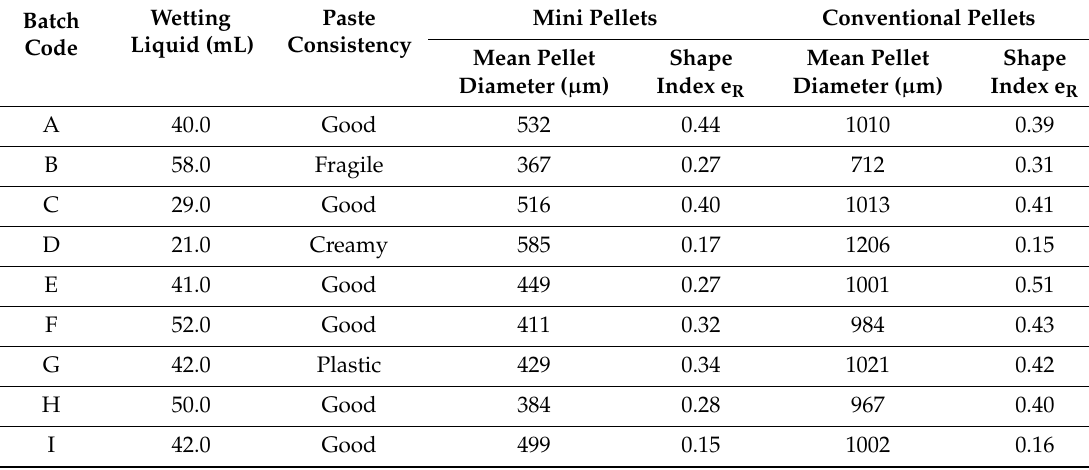
Table 3. Wetting liquid consumption, paste consistency, pellet size, and pellet shape of the experimental mini and conventional pellet batches.